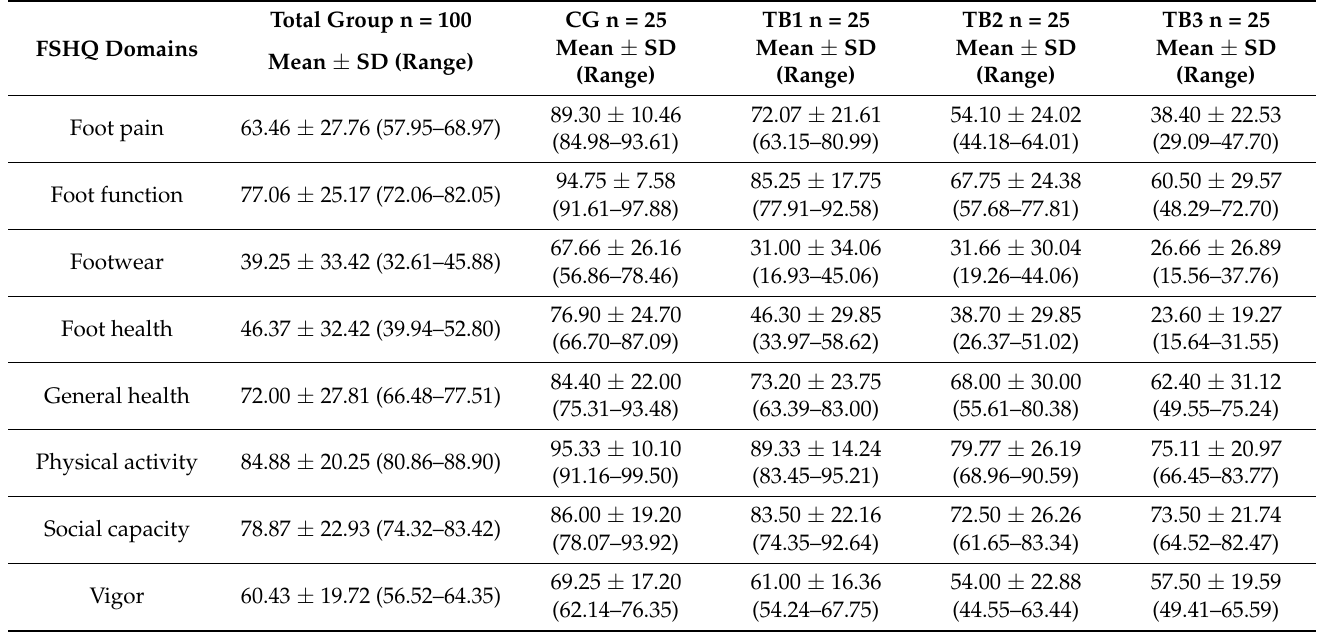
Table 6. Comparisons of Foot Health Status Questionnaire scores between different classifications of tailor’s bunion.